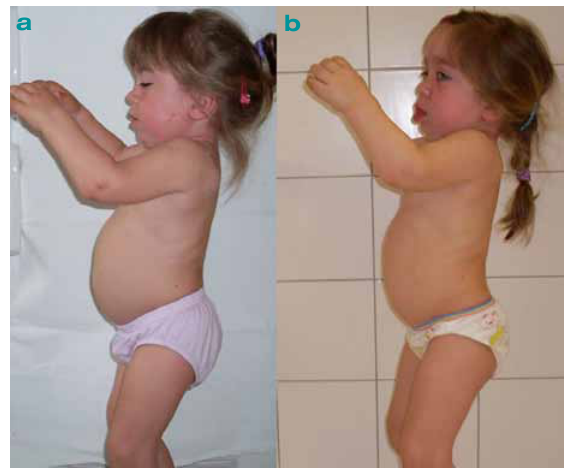
Figure 6. Active shoulder flexion in a patient with MPS VI at baseline and after 48 weeks of ERT with galsulfase. Mean restriction